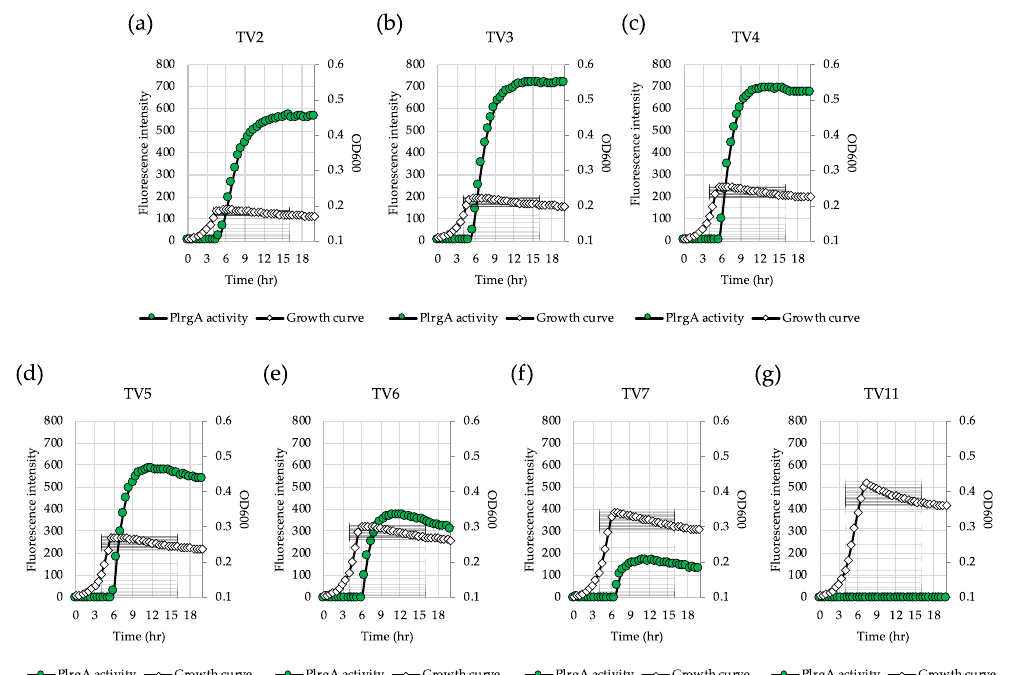
Figure 4. Low glucose dependence of P lrgA activity during growth in TV medium. The P lrgA-gfp reporter strain in the S. mutans wild type background was grown in TV medium, supplemented by 2 ( a ), 3 ( b ), 4 ( c ), 5 ( d ), 6 ( e ), 7 ( f ) and 11 mM ( g ) of glucose. Relative gfp expression (green circle) and OD 600 (white diamond) were monitored during growth on a plate reader (see Materials and Methods for details). The results are representative of three independent experiments.